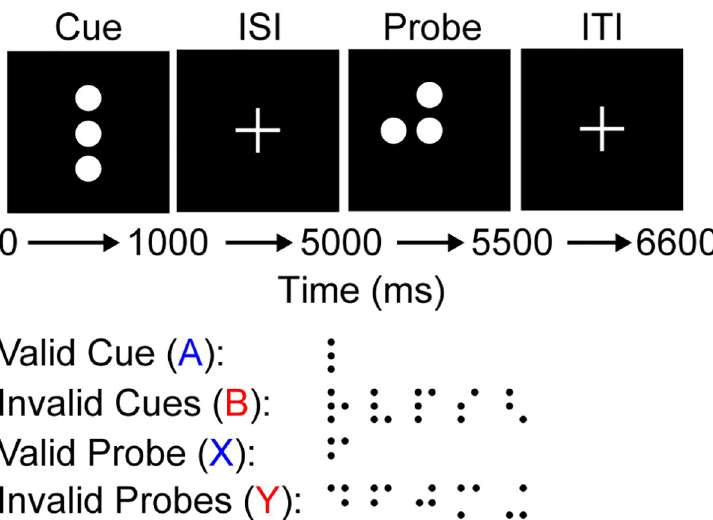
Fig 1. DPX task trials. Example of the DPX task as experienced by a participant. The participant observes various dot patterns during the cue and probe periods for 1 and 0.5 seconds, respectively. Between the cue and probe there is an interstimulus interval (ISI) of 4 seconds and after the probe an intertrial interval (ITI) of 1.1 seconds. The dot patterns can be grouped into A or B cues and X and Y probes. The A and X stimuli are considered ‘valid’ and, when observed sequentially (AX), the participant should make a left response; in all other cases the participant should makes a right response (i.e., for AY, BX, and BY combinations). There are a multiple B cues and Y probes, which can be used to assess the participants’ ability to differentiate them from the valid stimuli. Participants typically engage with 150 cue- probe trials that are 64% AX, 16% AY, 16% BX, and 4% BY. These are unevenly distributed to create a prepotent response towards the left (AX)